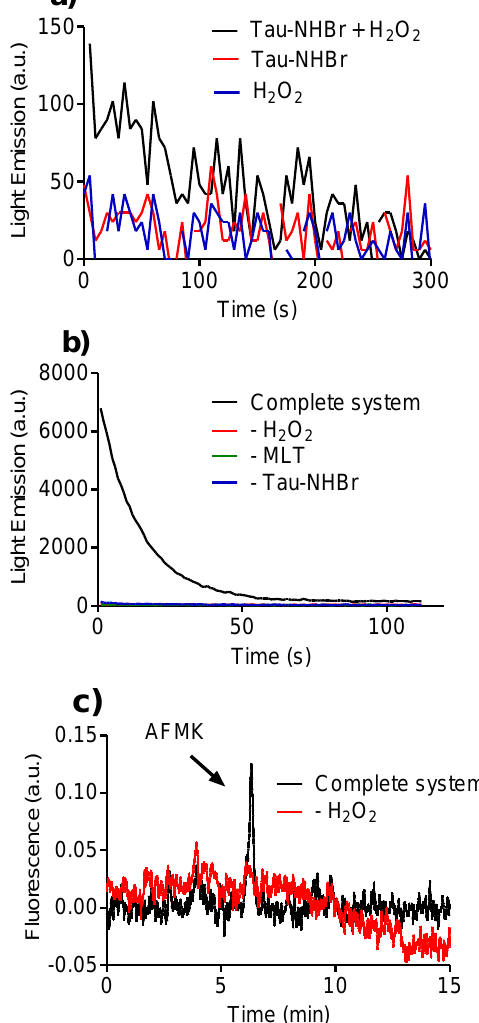
Figure 10. Evidence of oxygen singlet production. ( a ) Intrinsic light emission by the reaction of 0.25 mM Tau-NHBr with 5 mM H 2 O 2 in 50 mM phosphate buffer, pH 7.0; ( b ) Melatonin-mediated light emission by the reaction consisting of 0.25 mM Tau-NHBr with 5 mM H 2 O 2 and 1 mM melatonin in 50 mM phosphate buffer, pH 7.0 (complete system); ( c ) HPLC analysis of the reaction mixture and evidence of the formation of AFMK (peak at 6 min) obtained by comparison with a pure AFMK.